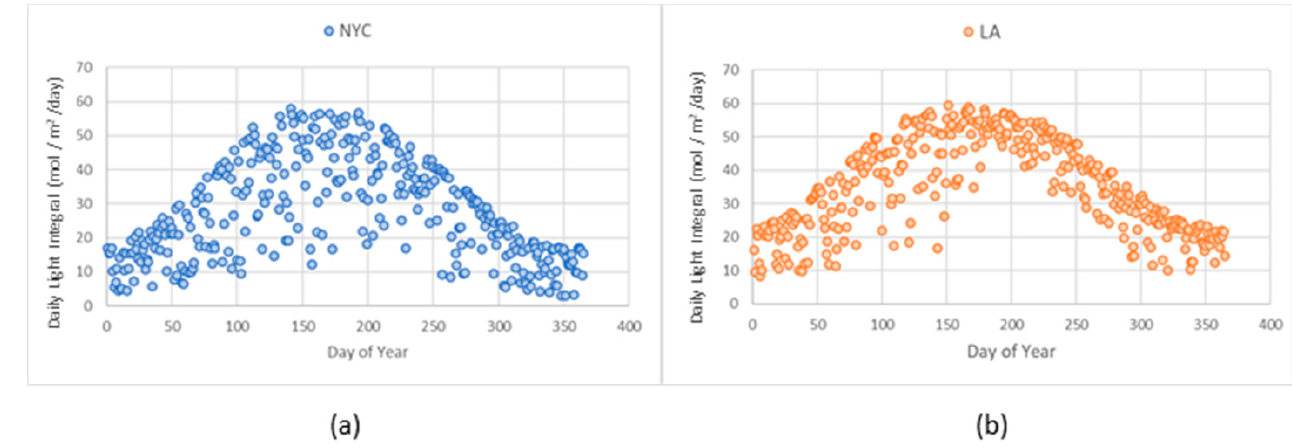
Figure 3. Daily light integral (mol · m − 2 · day − 1 ) in ( a ) New York City and ( b ) Los Angeles.